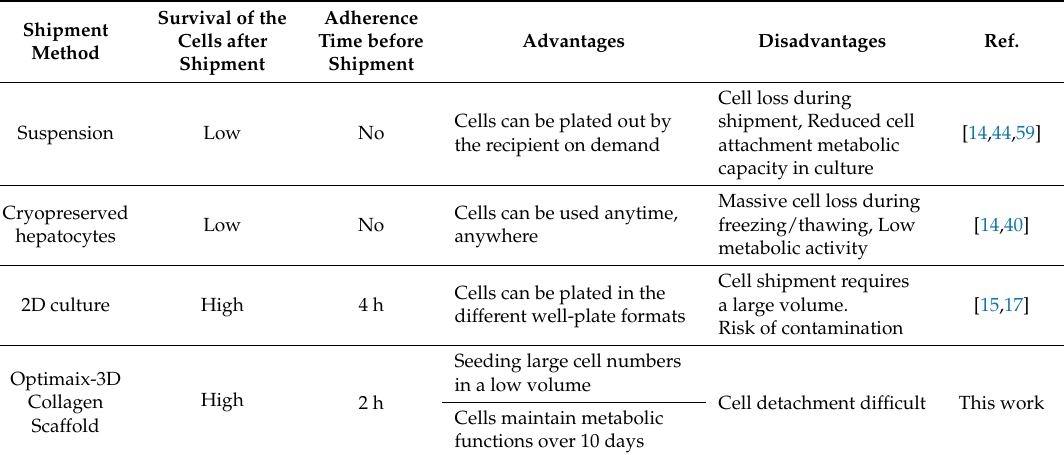
Table 4. Comparison of various shipment